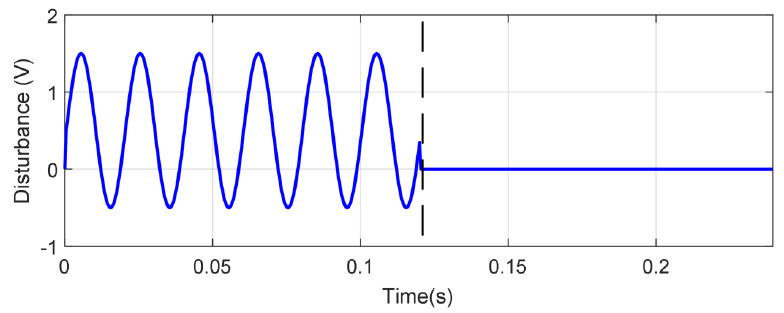
Figure 7. Disturbance used in test 2.